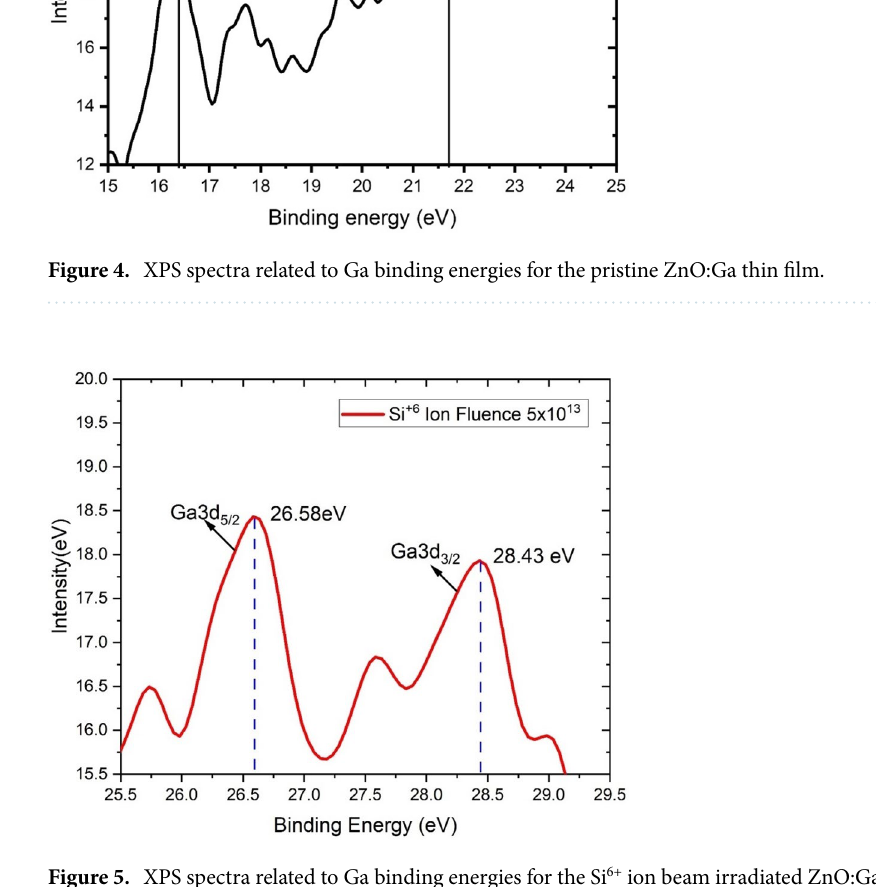
Figure 5. XPS spectra related to Ga binding energies for the Si 6+ ion beam irradiated ZnO:Ga thin